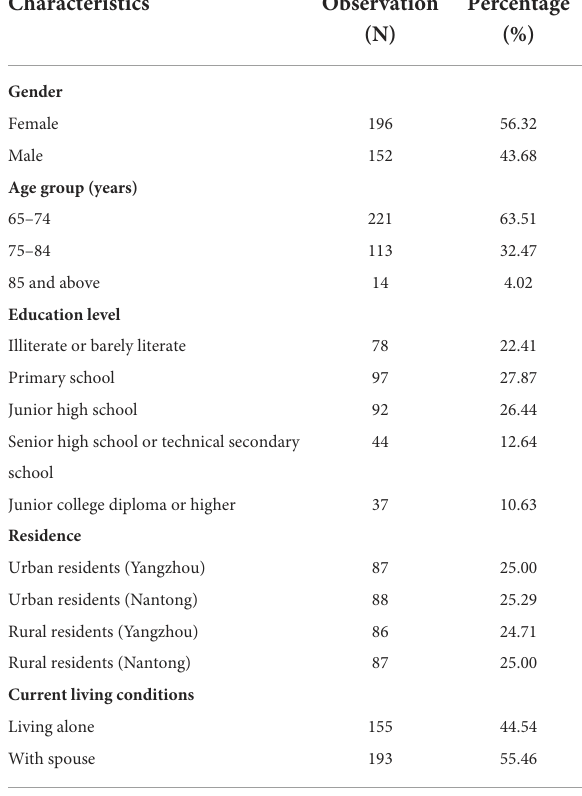
TABLE 3 Distribution of participants’ sociodemographic characteristics ( N = 348).